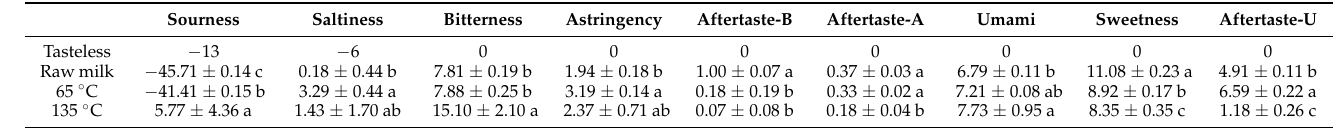
Table 3. Taste value of milk E-tongue with different processing temperatures.